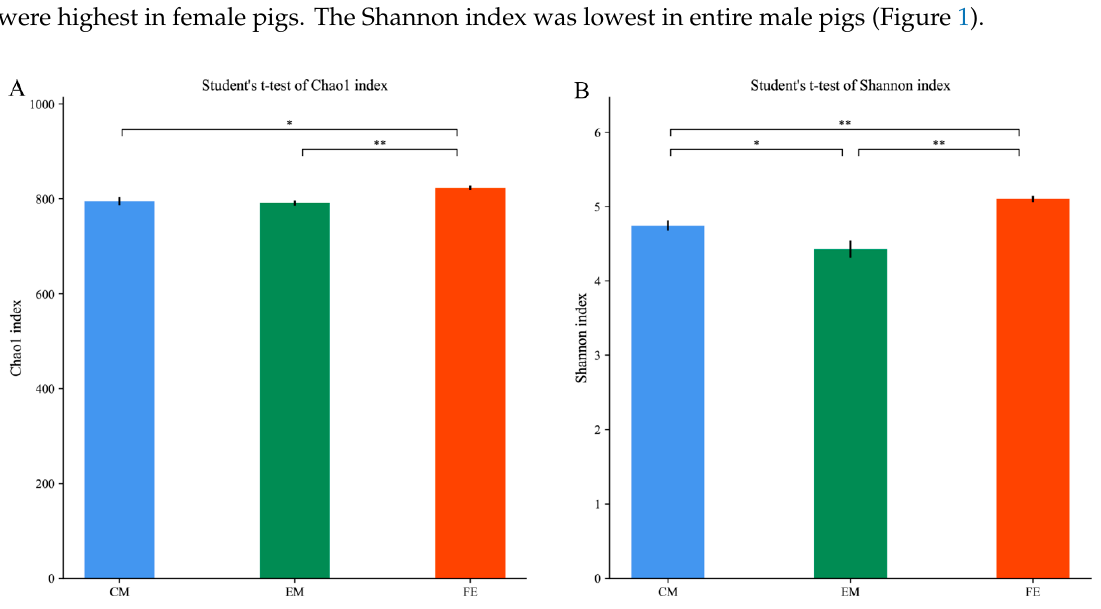
Figure 1. Dynamic changes in intestinal microorganism alpha diversity. ( A ) Chao1 index; ( B ) Shannon index. Different letters represent significant differences in alpha diversity indices based on Student’s t ‐ test (* p < 0.05, ** p < 0.01).